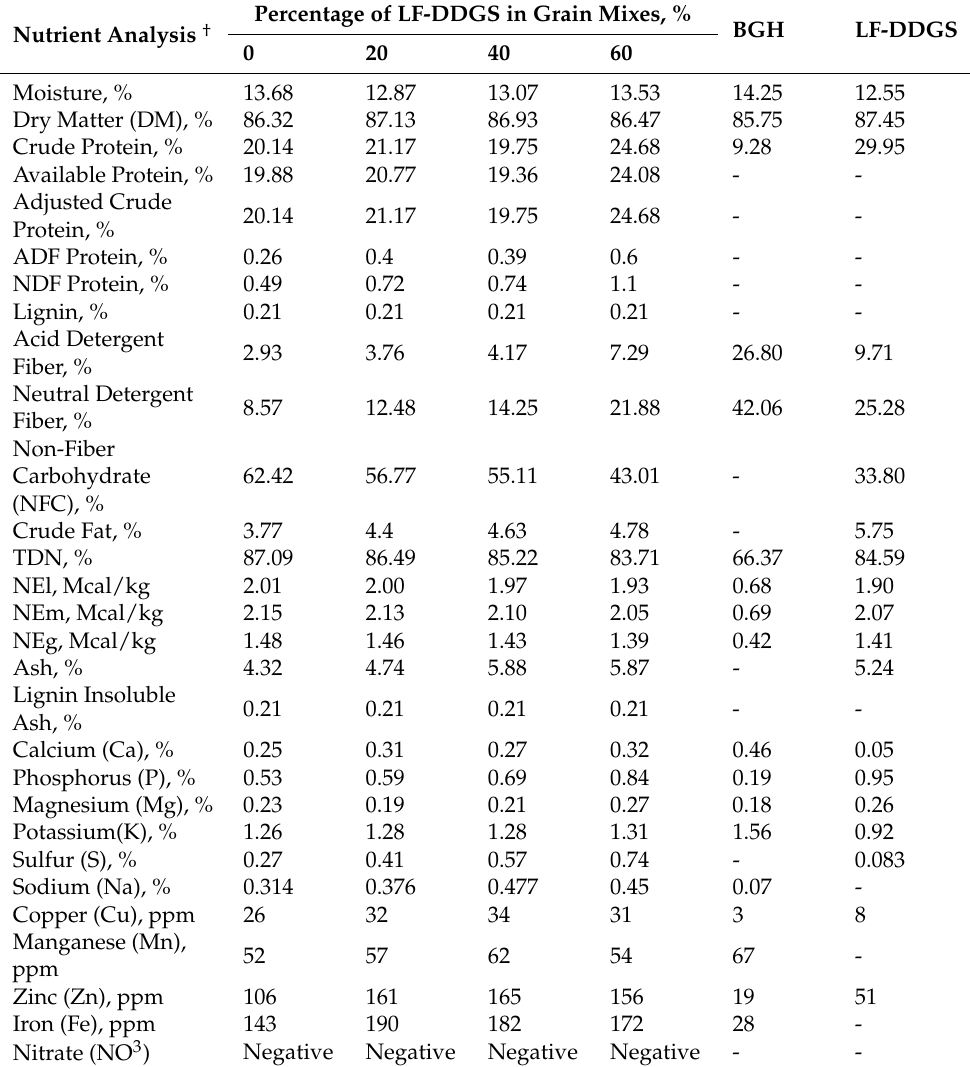
Table 2. Analyzed chemical composition of grain mixes, Bermudagrass hay (BGH), and low-fat distillers dried grains with solubles (LF-DDGS) used in experimental diets fed over 84 days to growing castrated male